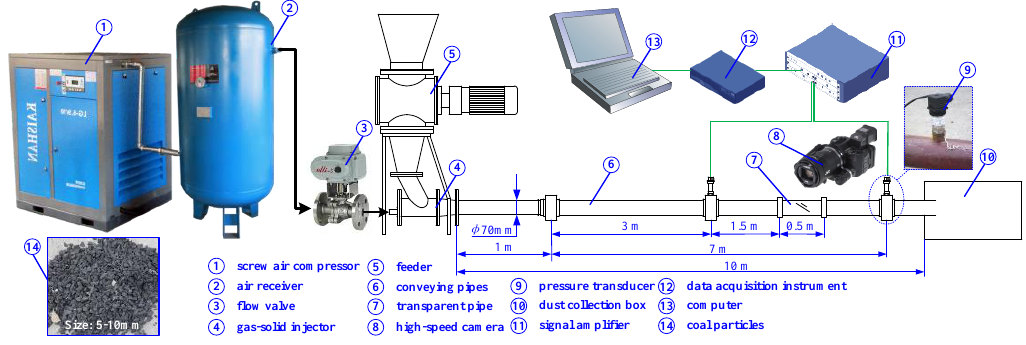
Figure 5. Experimental system of horizontal pneumatic conveying.